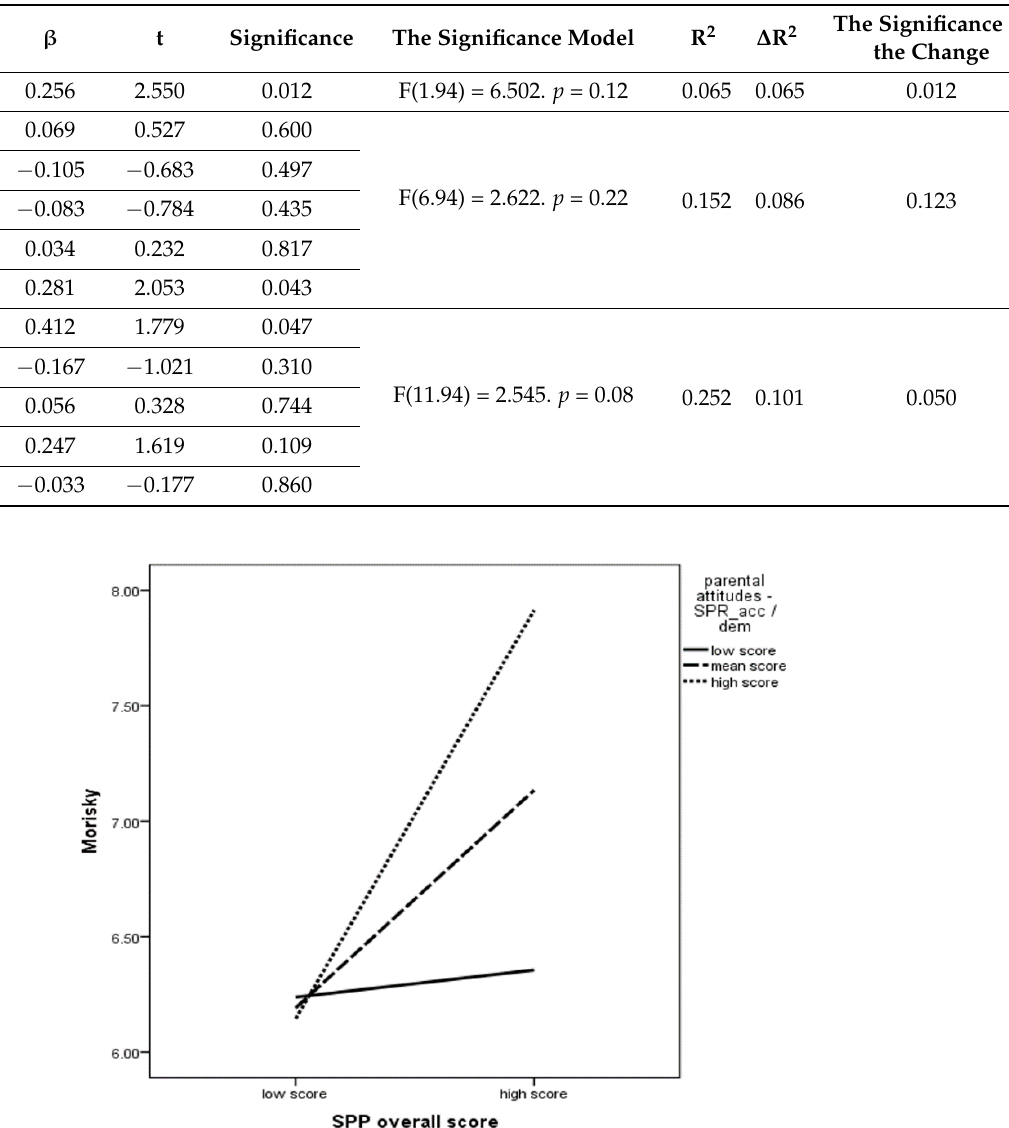
Table 3. Clinical predictors of regularity of drug intake.